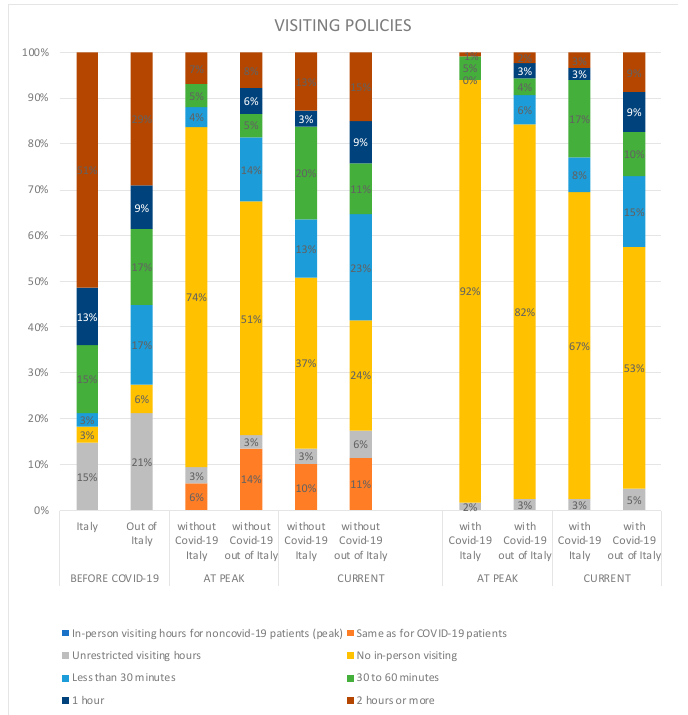
Figure 1. Comparison of visiting policies in Italy and outside Italy over three timepoints (before COVID-19, at peak, and at the time of the survey) according to COVID-19 status of patients. As shown in Table 2, at the time of the survey, in Italy and worldwide, most ICUs (64% in Italy and 68% outside of Italy) had written visiting policies designed or revised for the COVID-19 pandemic, despite the government not directly mandating any restriction policy in 43% of the cases in Italy and 48% outside Italy.